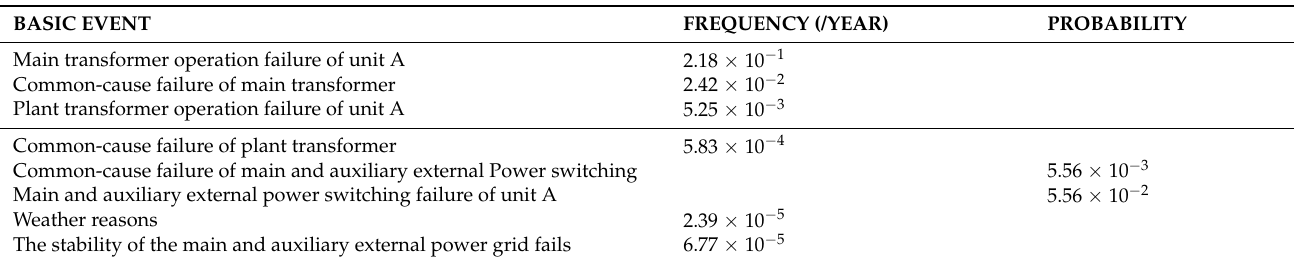
Table 1. List of key